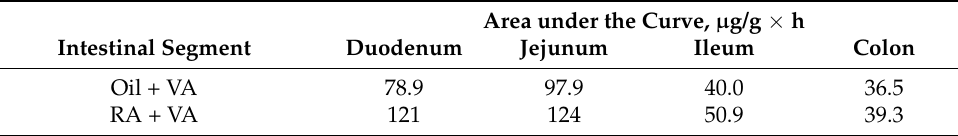
Figure 3. Regional VA distribution vs. time after oral administration of VA supplement in neonatal rats: ( A ) Duodenum; ( B ) Jejunum; ( C ) Ileum; ( D ) Colon. Data are presented as means ± SEM, n = 4–6 pups/time/group. Table 3. VA mass accumulation in each intestinal segment after VA supplementation in oil-pretreated and RA-pretreated